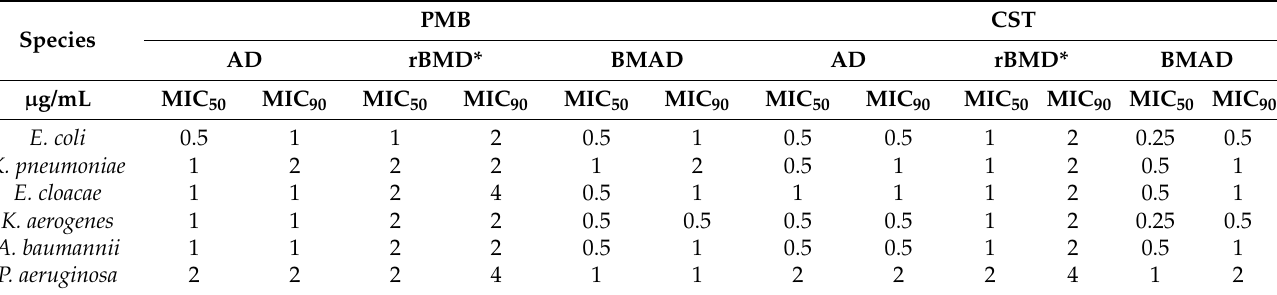
Table 1. MIC 50 and MIC 90 of